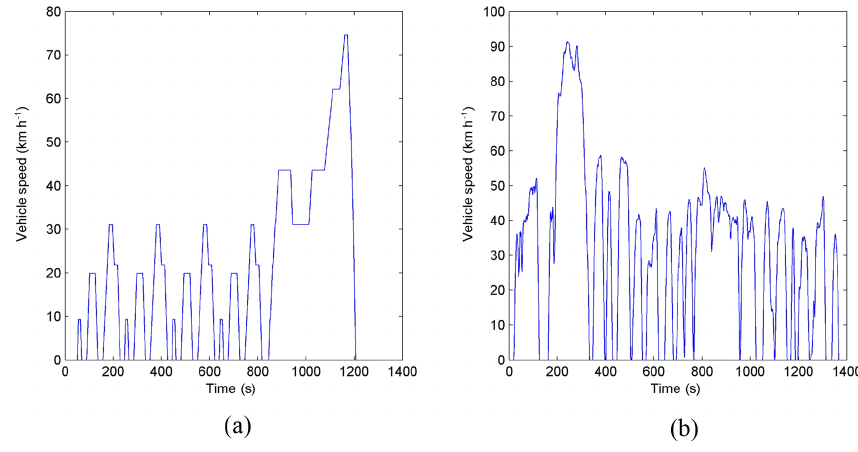
Figure 9. Typical city driving